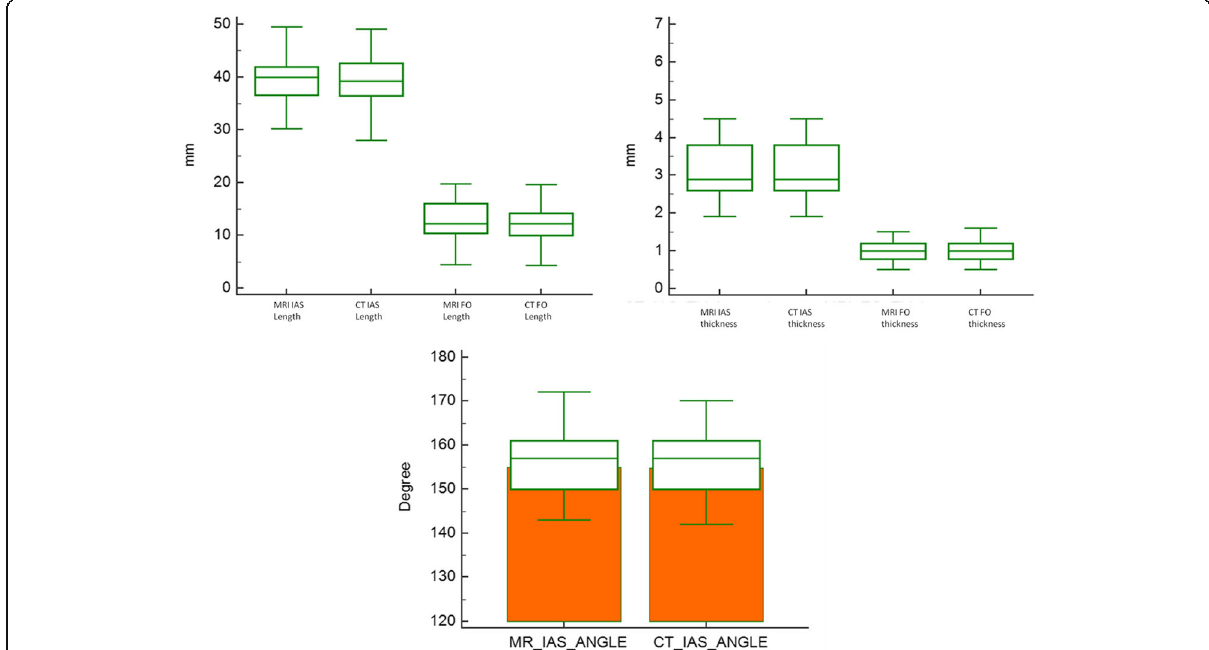
Fig. 2 Comparison graphs of both techniques. It demonstrates the close relationship between various measurements of the interatrial septum